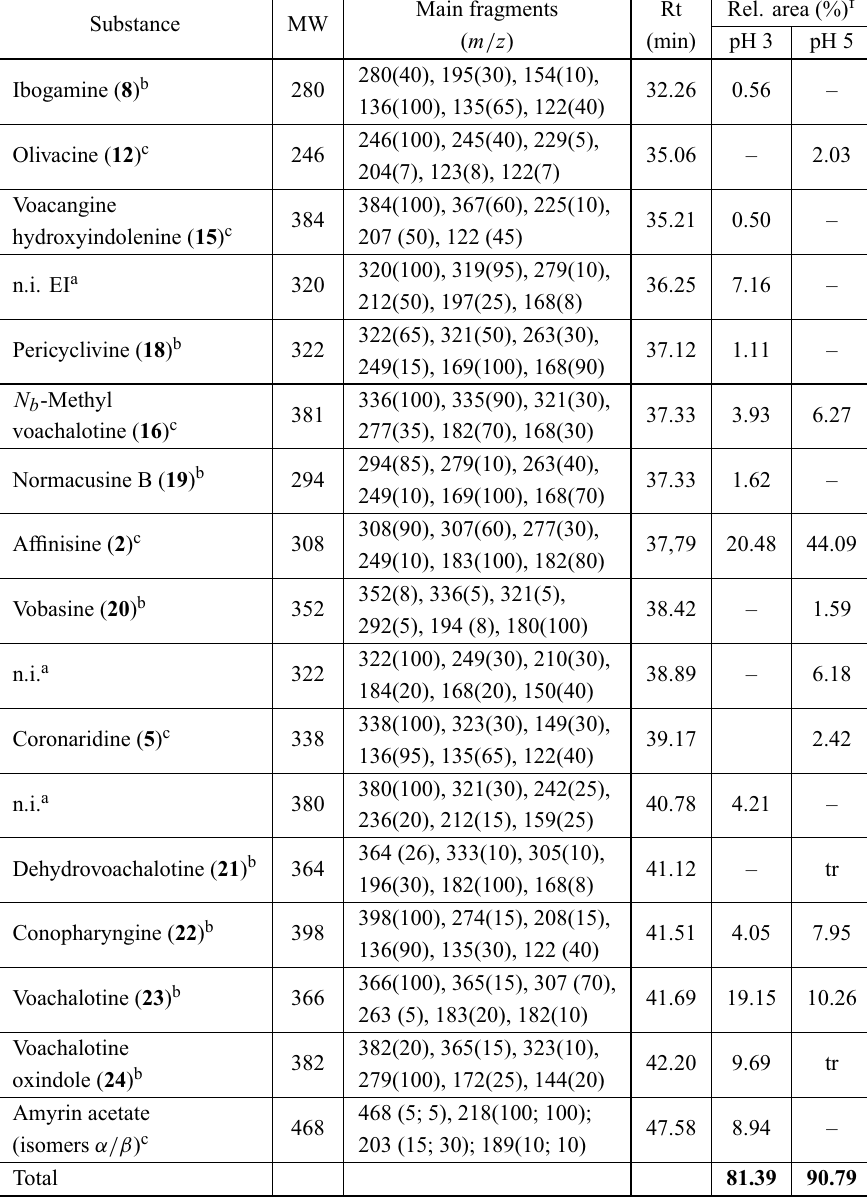
Gas Chromatography-Mass Spectrometry (GC-MS) and Gas Chromatography (GC-FID) analyses of pH3 and pH5 fractions obtained from T. laeta stalk extracts